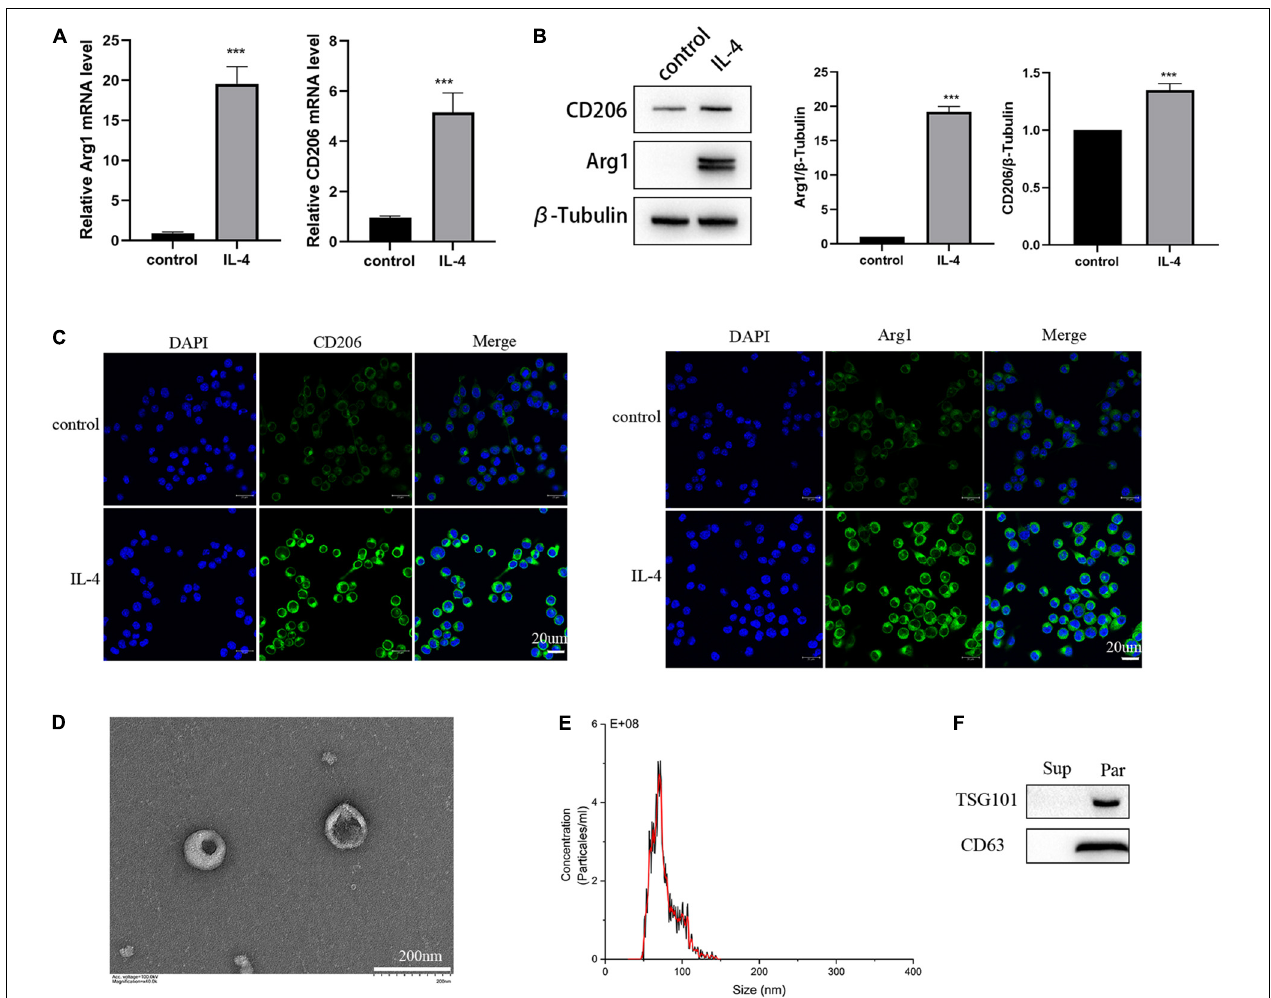
FIGURE 3 | Identification of the isolated polarized M2 microglia and exosomes. (A) The expression of M2 microglia markers Arg1 and CD206 detected by RT-PCR. (B) The expression of M2 microglia markers Arg1 and CD206 detected by Western blot analysis. (C) The expression of M2 microglia markers Arg1 and CD206 detected by immunofluorescence. (D) Images of M2-EXOs detected using TEM. (E) Measurements of particle sizes range of the isolated exosomes using NTA. (F) Detection of exosomal marker proteins CD63 and TSG101 using western blot. All experiments were repeated three times. *** P < 0.001 vs. control.